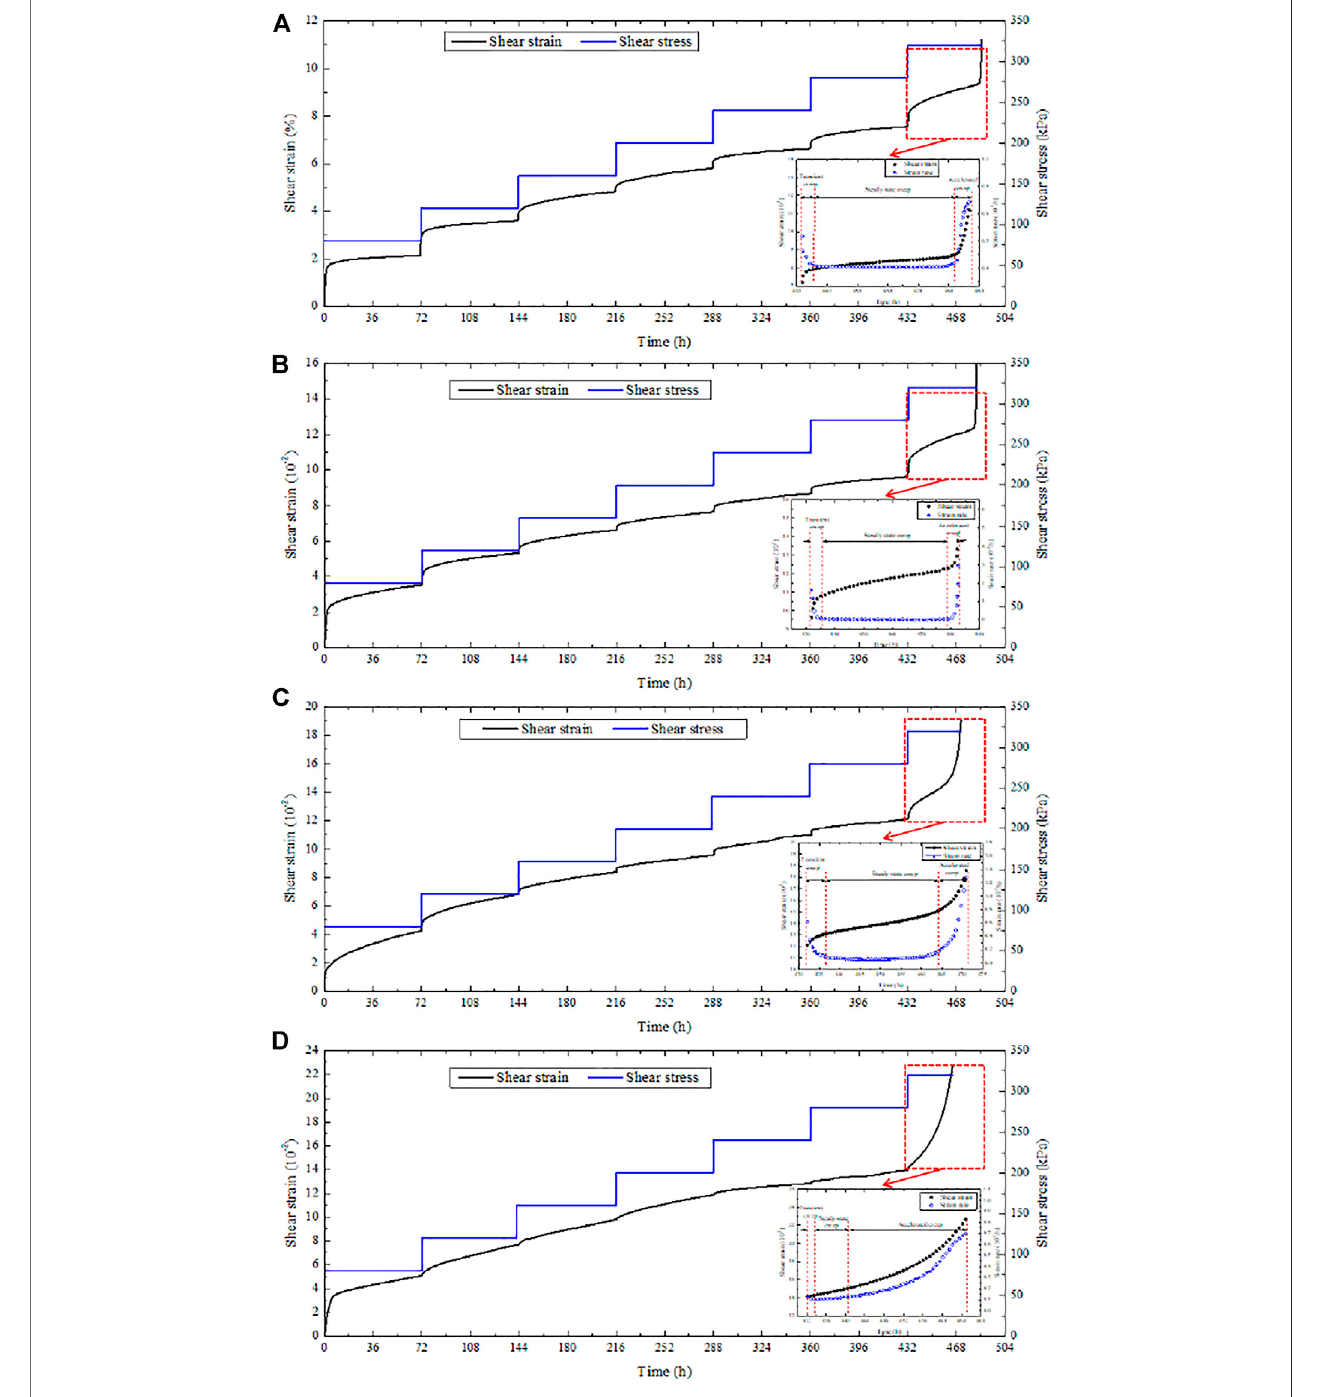
FIGURE 2 | Shear creep of samples with different water contents (A) 3.8%, (B) 7.9%, (C) 12.2%, and (D) 16.4%.